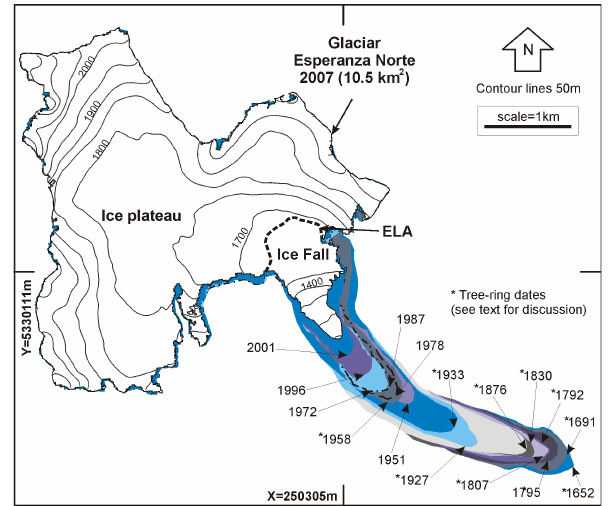
Fig. 5. Reconstruction of LIA and post-LIA fluctuations of Glaciar Esperanza Norte based on dendrogeomorphological dating of moraines, remote sensing and historical photographs. ∗ Tree-rings dates have inherent assumption and corrections, see Table 1 and Fig. 6. Note the position of the ELA in 2007 (dotted line) and the lo- cation of the ice fall that characterizes the longitudinal profile of the glacier. Thin black lines indicate elevation contour lines, for sim- plicity only a few are labeled. Coordinates X and Y in UTM 19 S WGS84